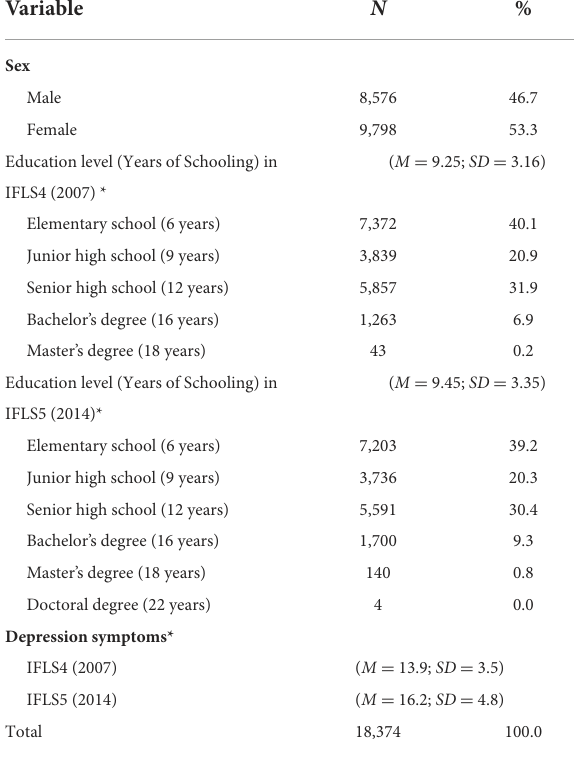
TABLE 1 Sociodemographic